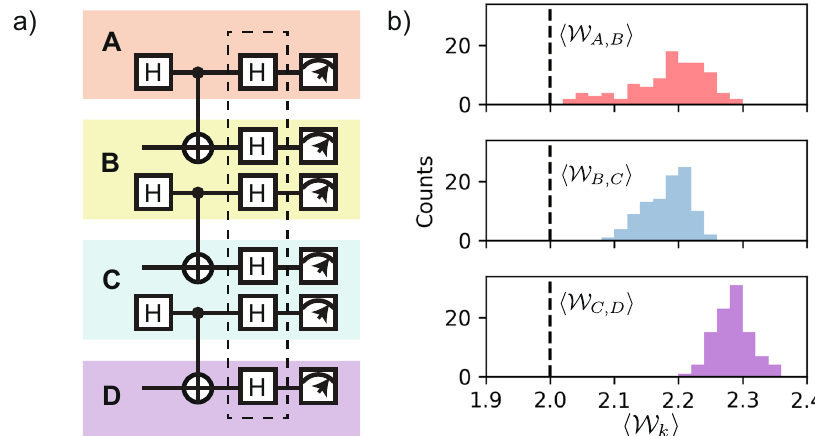
Fig. 4 Simultaneous Bell Inequality Violations. Disjoint, pair-wise entanglement is generated across chip boundaries via CNOT operations on inter-chip couplers compiled to CZ gates, with the optional basis change for evaluating either 〈 ZZ 〉 (no fi nal Hadamard) or 〈 XX 〉 (with fi nal Hadamard). No error mitigation or readout correction schemes were applied. b Histograms of the average values 〈 W k 〉 across 100 individual experimental runs using 10 4 shots in each measurement basis. The dashed line indicates the classical limit of 2.0. Because all three